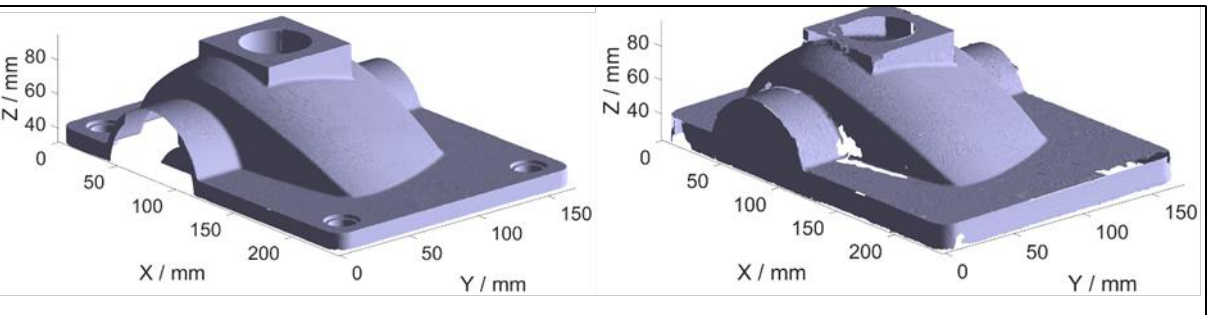
Figure 14. The experimental data of the matte object ( left ) and the experimental data of the reflective object ( right ).